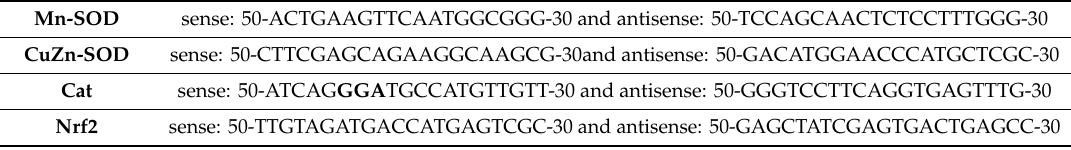
Table 2. Primer sequences used in